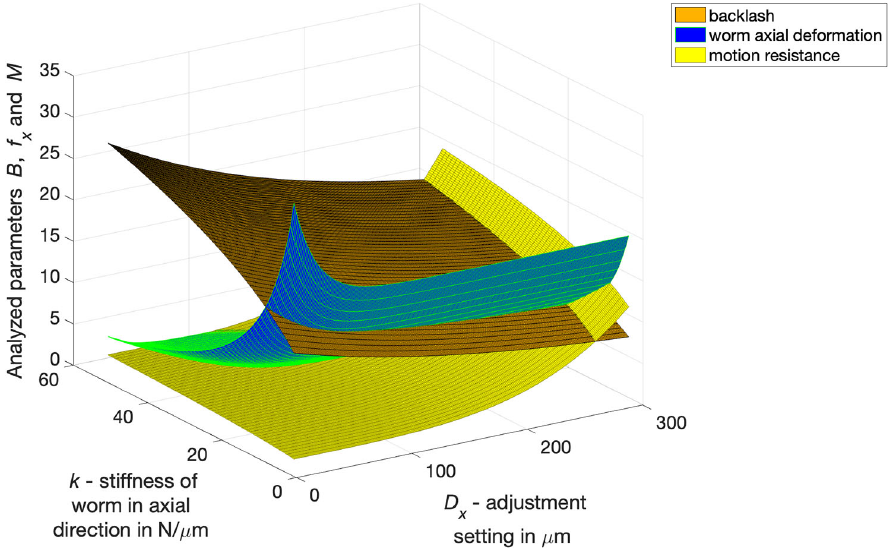
Figure 20. Backlash B in µ m as a function of adjustment setting n and axial stiffness k of the worm without a load (brown area), axial deformation f x of the worm for the tested drive (green area) and motion resistance M in Nm .